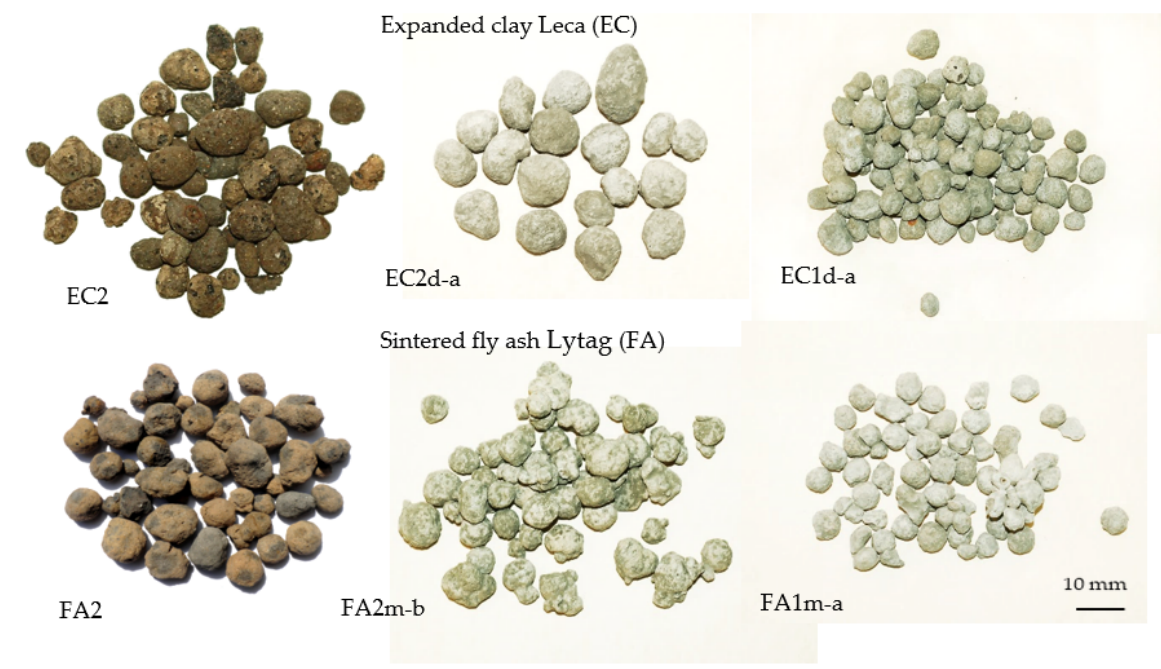
Figure 2. Examples of plain and impregnated lightweight aggregates used for research (LWAs symbols acc. to Table 1).